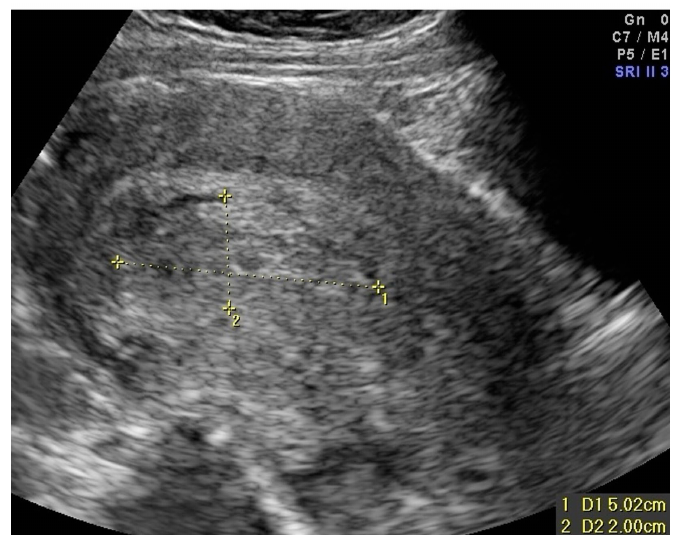
Figure 1. Ultrasound showing evidence of retained products of conception, demonstrated by echogenic, heterogeneous, and vascular intrauterine contents. Case courtesy of Dr Alexandra Stanislavsky, Radiopaedia.org, rID: 13852. Accessed at https:// radiopaedia.org/cases/retained-products-of-conception-2?lang=us.